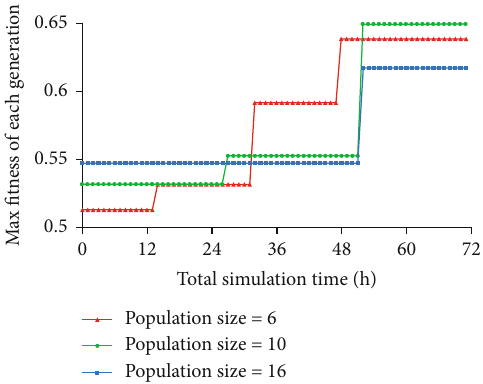
Figure 7: E ff ect of population size on fi tness